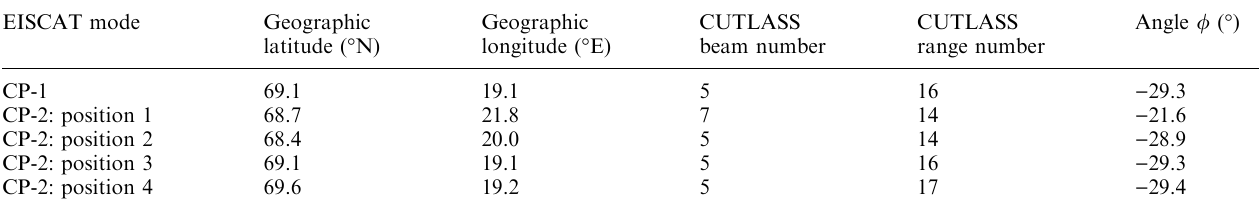
Table 1. Location of the F-region tristatic volume for EISCAT CP- 1 and the four pointing directions of CP-2, in terms of both geographic co-ordinates and position within the CUTLASS Finland EISCAT mode Geographic